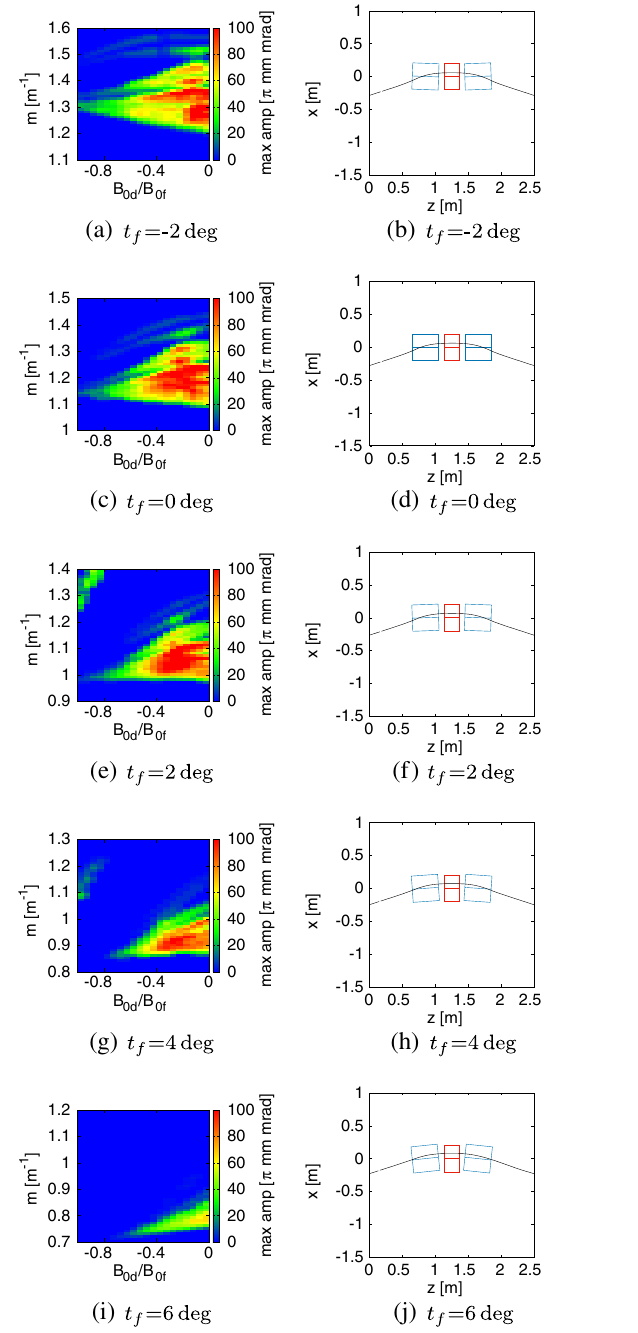
=B 0 FIG. 8. Stable area in m and B 0 space depending on radial d f =B 0 FIG. 7. Stable area in m and B 0 space depending on the displacement x of Bf with respect to Bd (a, c, e, g, i) and d f s tilt angle t of Bf with respect to Bd (a, c, e, g, i) and representative orbit for each case (b, d, f, h, j). Parameters of the f representative orbit for each case (b, d, f, h, j). Parameters of representative orbits are listed in Table the representative orbits are listed in Table III. away from the ring center and Bd moves toward Figure 7 shows the stable area when t changes f the ring center. With a tilt imposed on Bf, the range of from − 2 to þ 6 degrees. A positive angle indicates m giving stable optics is reduced. With a displace- Bf is relatively more aligned with the orbit. Figure 8 =B 0 ment x , a stronger correlation between m and B 0 shows the stable area when x changes from − 0 . 04 to s d f s þ 0 . 04 m. A positive displacement indicates Bf moves appears.